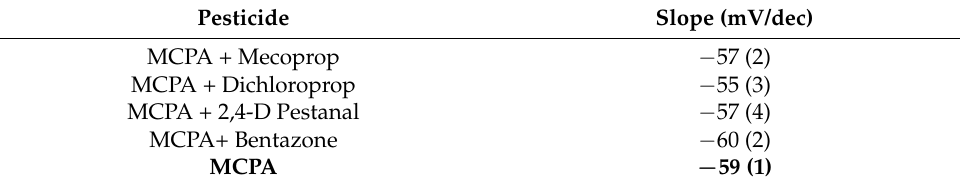
Table 3. Slope of the calibration curves performed in solutions containing 0.5 µ mol L − 1 of MCPA and increasing quantities of each interferent. For the phenoxy herbicides, in the x -axis of the calibration plots, the logarithm of the sum of both herbicides’ concentrations is reported; conversely, the loga- rithm of the MCPA concentration was considered for the calibration plot obtained in the presence of